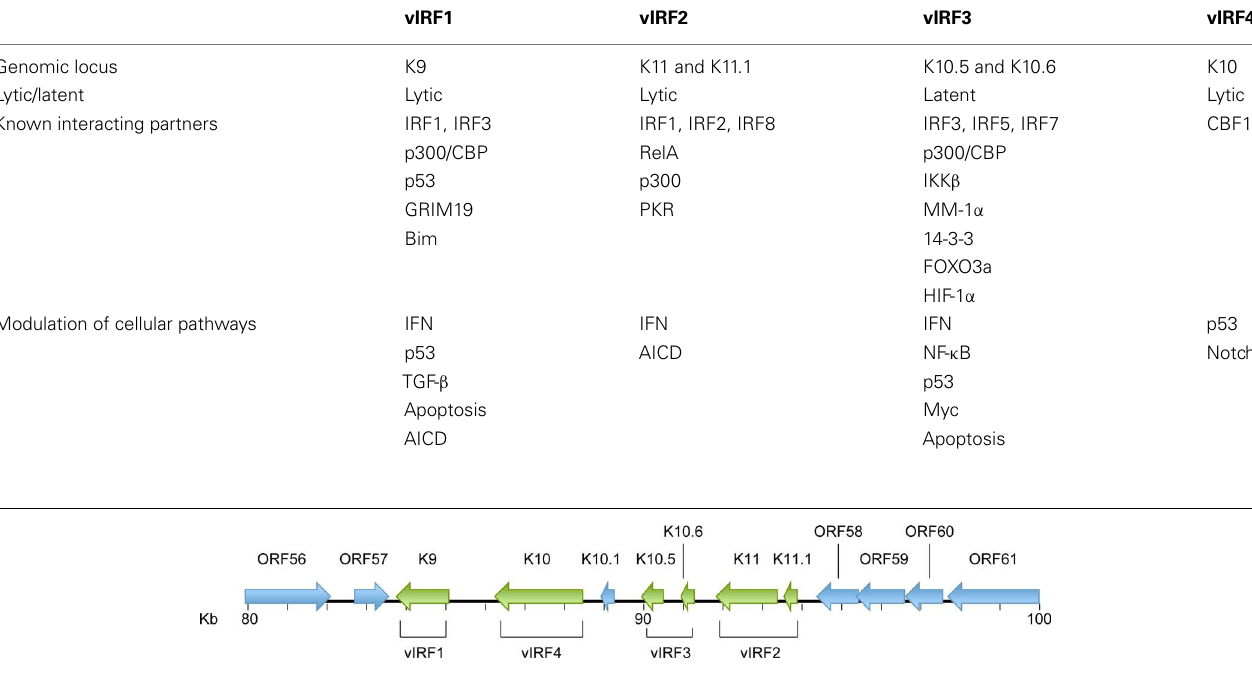
(Lallemand-Breitenbach and de The, 2010). The vIRF2